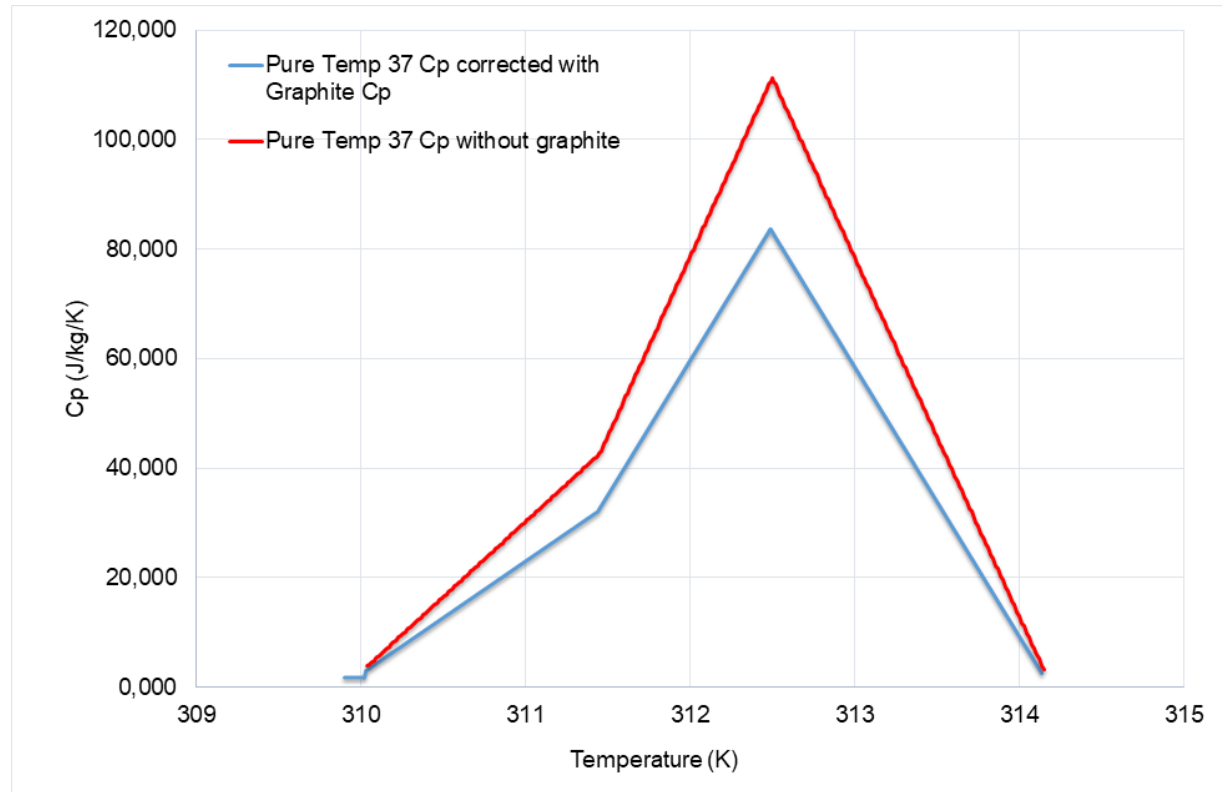
Figure 4. Equivalent specific heat capacity of the pure PCM versus that of the composite PCM-EG.